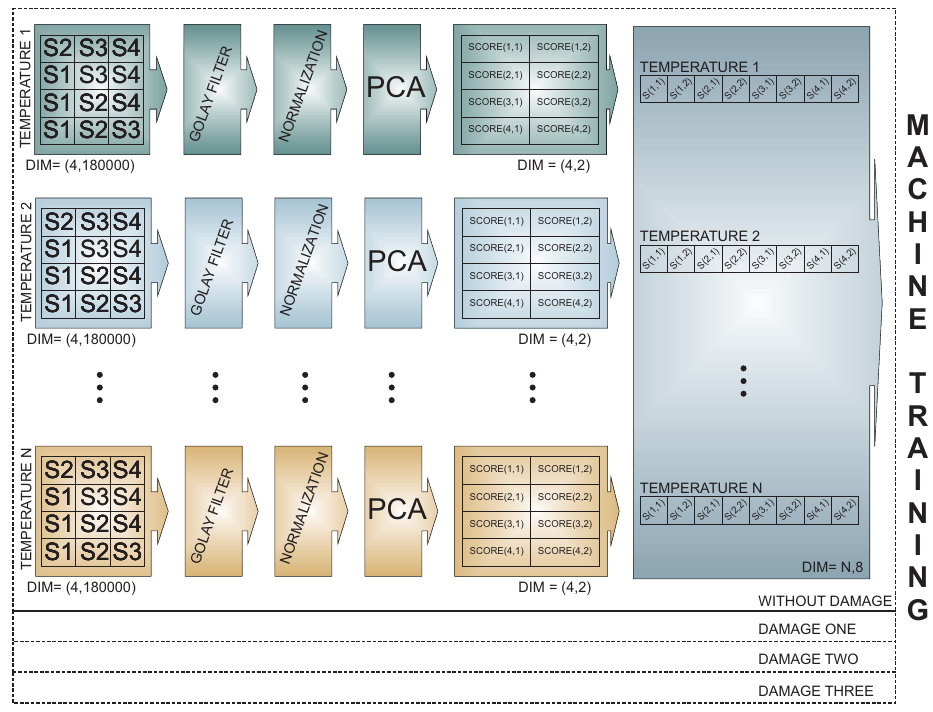
Figure 6. Methodology and training